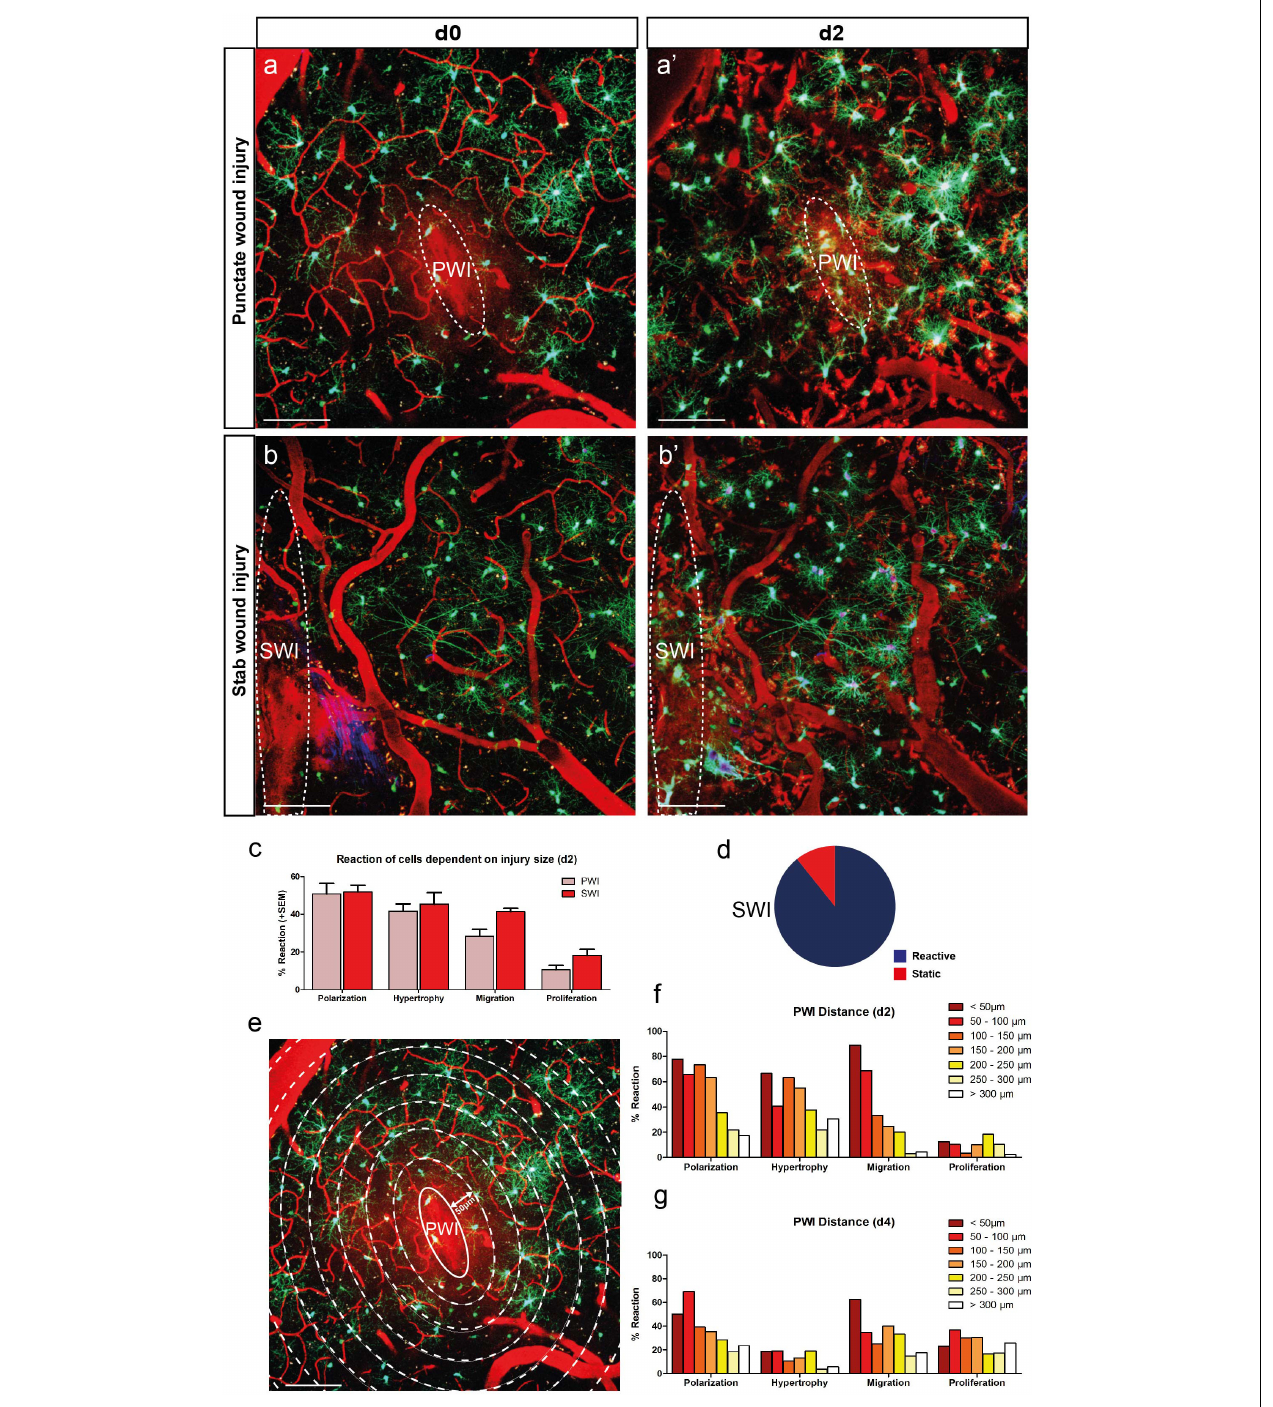
FIGURE 3 | The degree of NG2-glia reaction depends on the size and proximity to the injury. (a,b) Images of the NG2-glia reaction between d0 and d2 after PWI (a,a’) and the bigger stab wound injury (SWI) (b,b’) . (C) NG2-glia show a stronger reaction after SWI compared to PWI (mean + SEM; n = 8 mice for PWI and n = 3 mice for SWI) with a lower percentage of static cells at 2dpi (d; compare to Fig. 1e). (e–g) Cells in closer proximity to the injury show increased reactivity compared to the ones further away from the lesion core at d2 (e,f) . This difference was less pronounced at 4dpi (g, polarization represents cells directed toward the injury; n = 220 cells from 8 animals at d2 and n = 180 cells from 6 animals at d4). Images show maximum intensity projections of 30 µ m deep stacks. Scale bars represent 100 µ m.